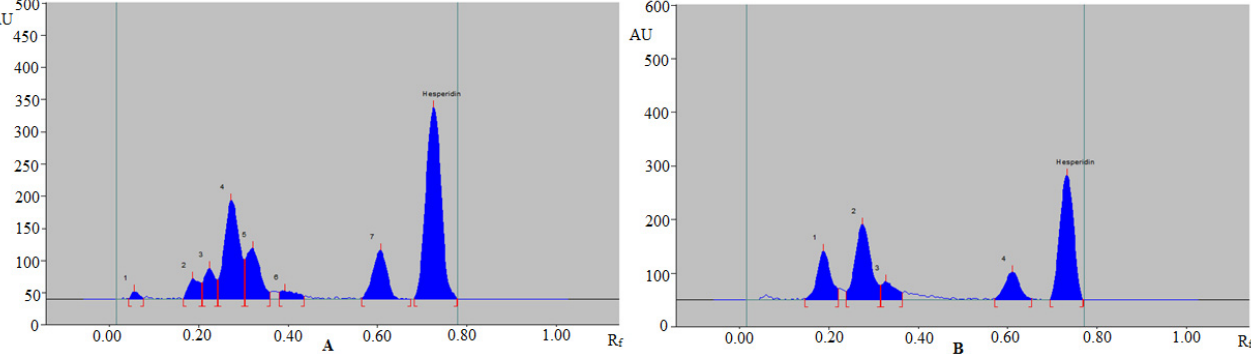
Figure 4. Spectrodensitograms of HSP in methanolic extract of ( A ) grapefruit peels and ( B ) lemon feels obtained using RP-HPTLC